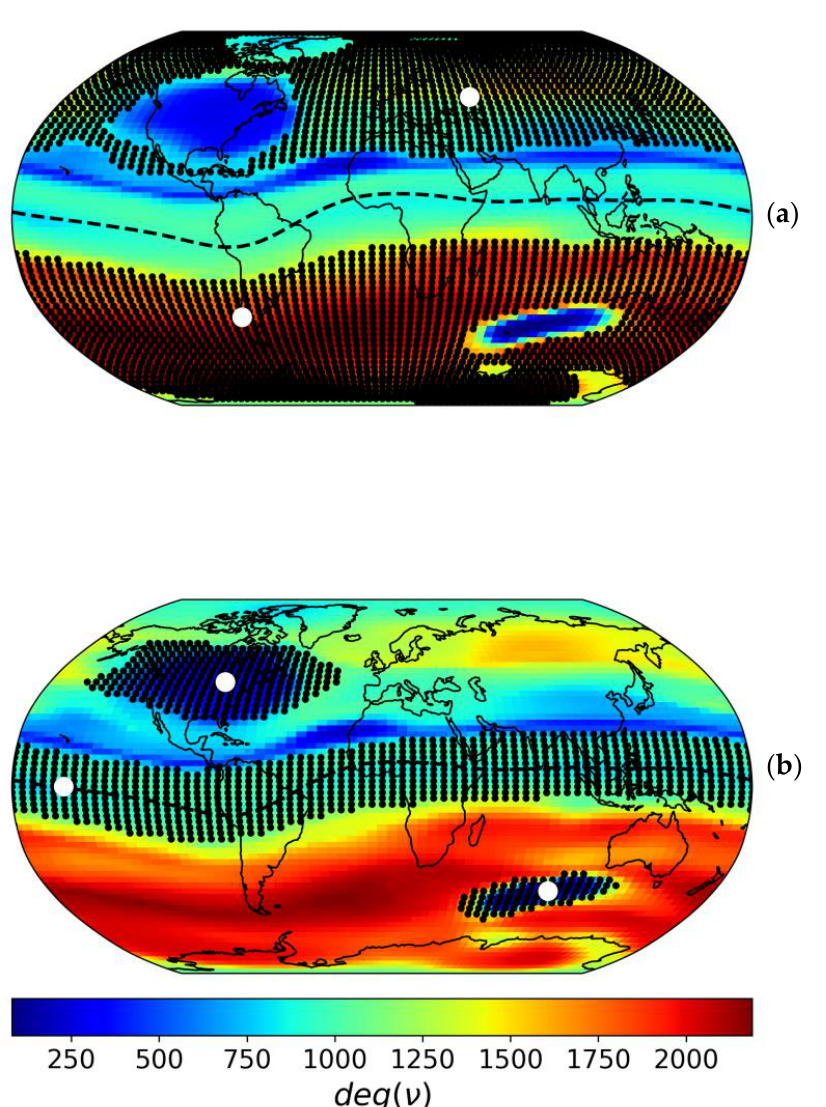
Figure 3. Ionospheric network. Color indicates the degree—how many links each node υ of the network has. Dashed lines on both panels indicate the geomagnetic equator. A large white circle is an example of a node in the chosen region, and small black circles are the nodes directly linked with it (so-called neighbors). Panel ( a ) shows nodes ( − 75 ◦ E, − 42.5 ◦ N) and (50 ◦ E, 52 ◦ N) with their neighbors in the regions of the North American and Australian anomalies. Panel ( b ) shows node ( − 155 ◦ E, 0 ◦ N) in the equatorial region, node ( − 85 ◦ E, 45 ◦ N) in the northern hemisphere and node (90 ◦ E, − 45 ◦ N) in the southern hemisphere with their neighbors.